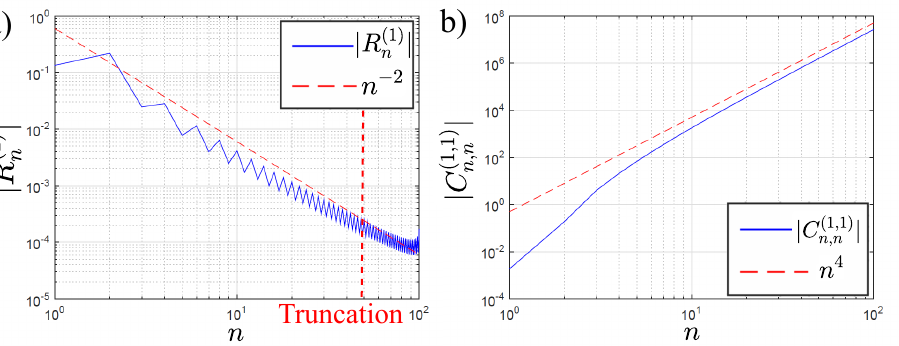
( 1 ) Figure 5. ( a ) Reflection coefficient R n of the first order for N − = 100 modes. ( b ) Evanescent forcing coefficients C ( 1,1 ) n , n at the second order for N − = 100